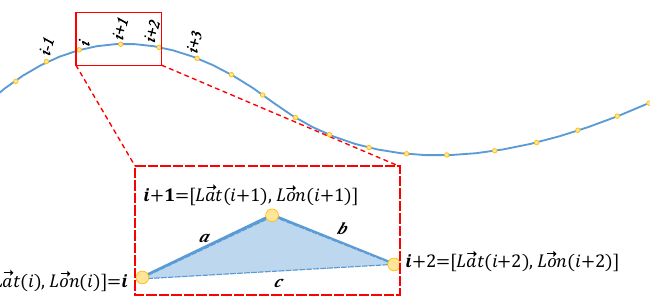
Figure 3. Concept illustration of the triangle formed by three consecutive points of the railway track used to find the curvature